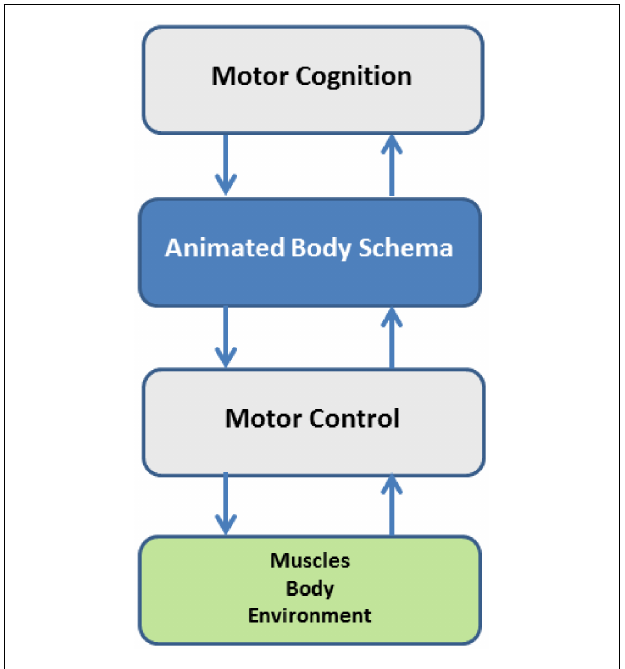
FIGURE 1 |The body schema as a computational middleware, separating motor cognition from motor control, but integrating them in the framework of embodiment